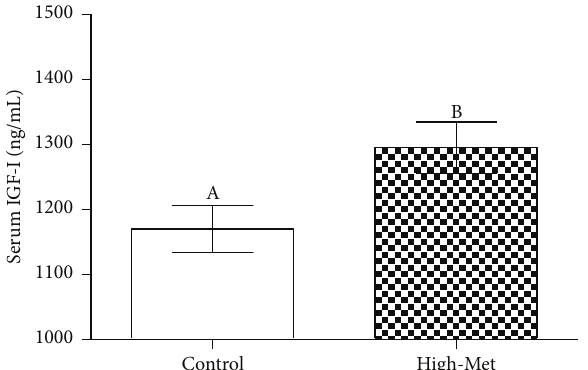
Figure 2: Serum levels of IGF-I when arthritic rats ate a high-Met diet. Data are shown here as means ± SEM ( 𝑛 = 8 ). A , B The varying letters indicate statistical significance in the divergences of the high-Met and control groups ( P < 0.05).